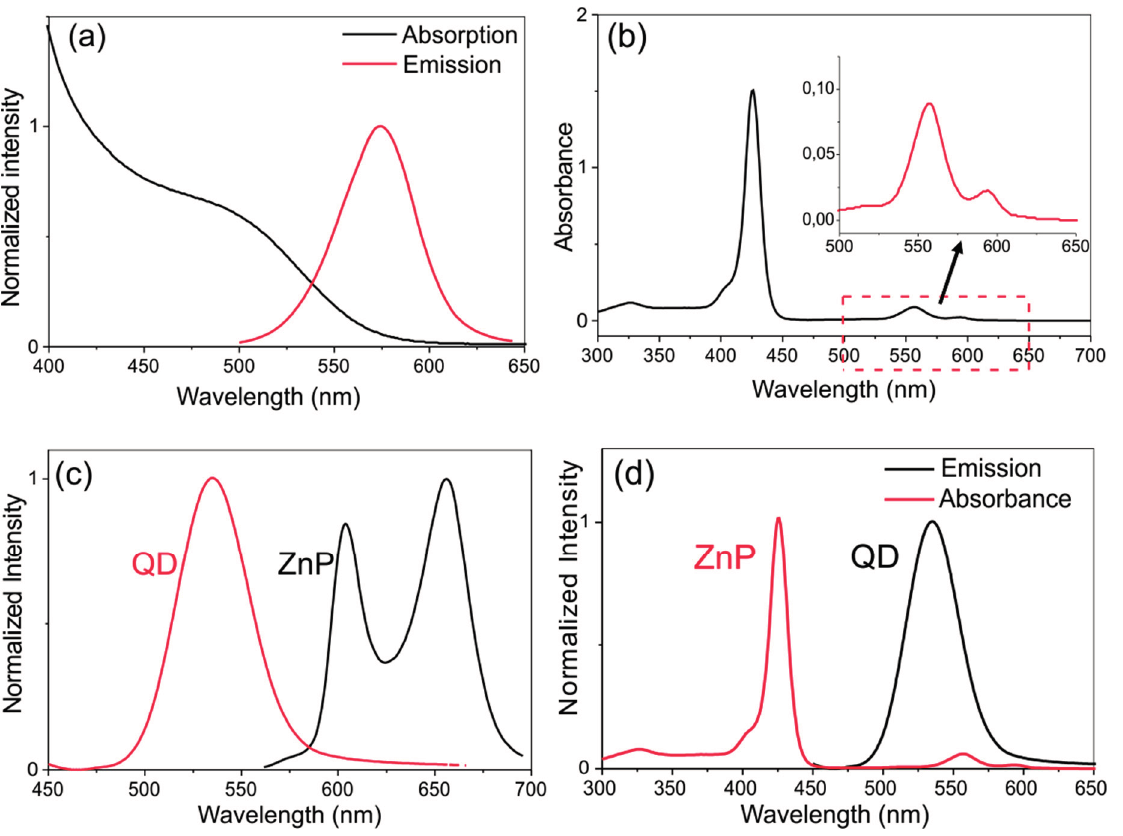
Figure 3. ( a ) Absorption and emission spectra of CdTe-MSA QDs (Exc: 460 nm); ( b ) absorption spectrum for the ZnP (the insert amplified the 500–650 nm spectral range); ( c ) superposition of the normalized emission spectra of CdTe QDs and the ZnP solution; ( d ) normalized absorption spectrum of ZnP and emission spectrum of CdTe QDs ( λ exc = 460